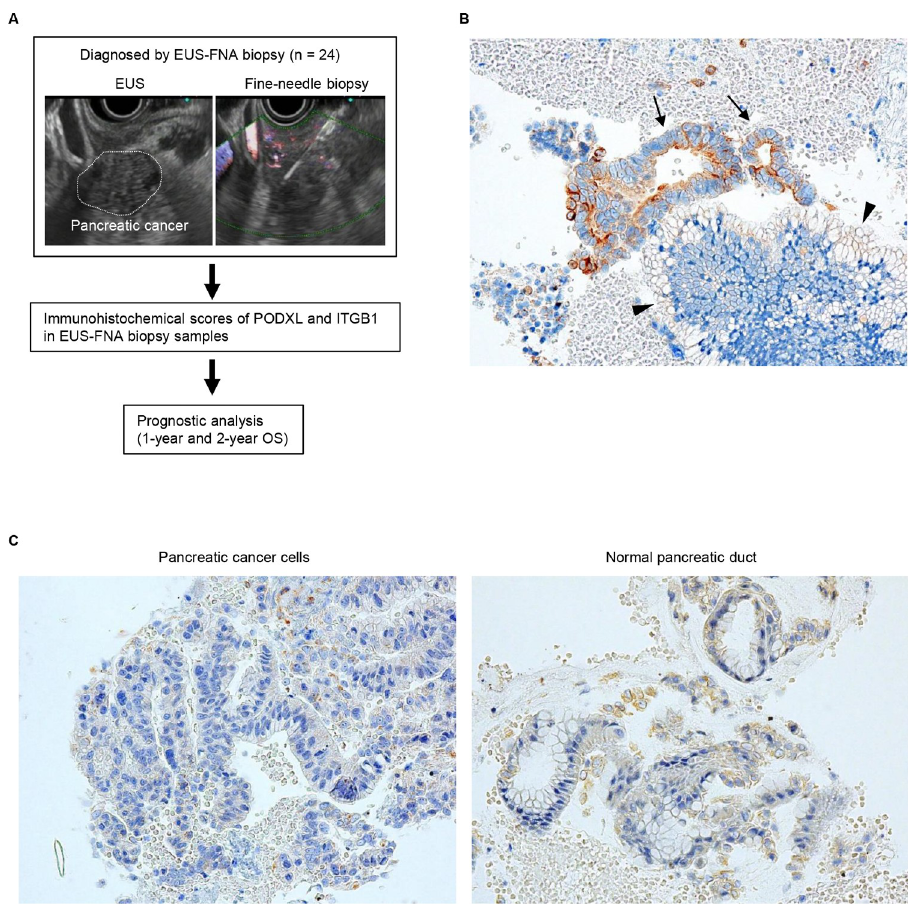
Fig 1. Expression of PODXL in PDAC tissues obtained by EUS-FNAB. (A) Study flow chart. (B, C) Representative immunohistochemical staining of PDAC tissue samples using anti-PODXL antibody showing (B) high and (C) low expression of PODXL. Arrows, PDAC cells; arrowheads, normal pancreatic duct epithelium. Magnification: × 400.